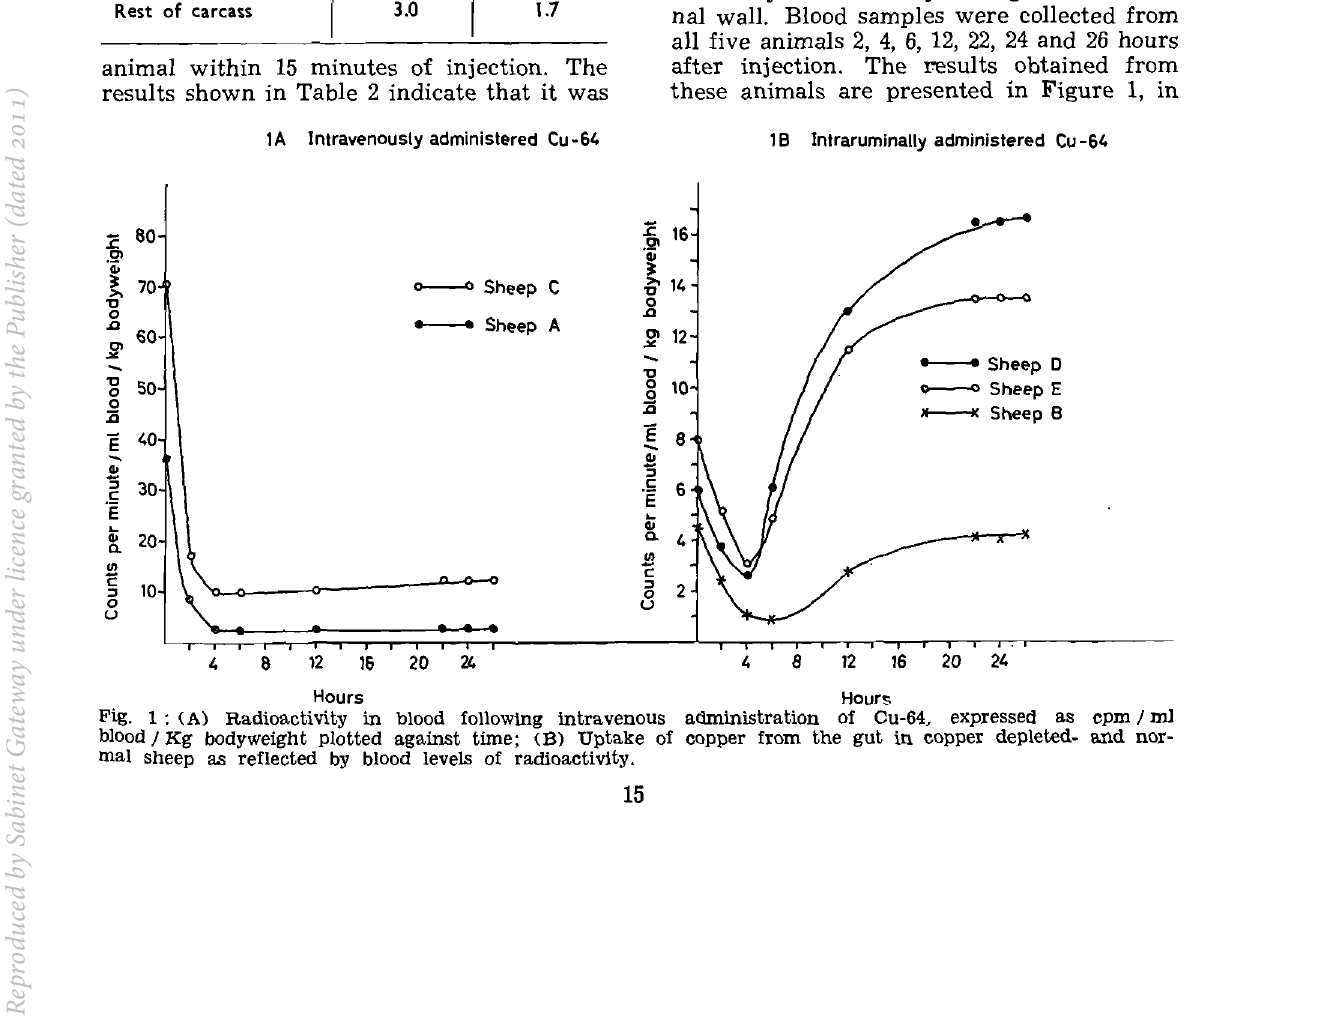
TABLE 2: PERCENTAGE DISTRIBUTION OF Cu-64 RADIO-ACTIVITY IN TWO SHEEP FOLLOWING INTRAVENOUS ADMINISTRATION